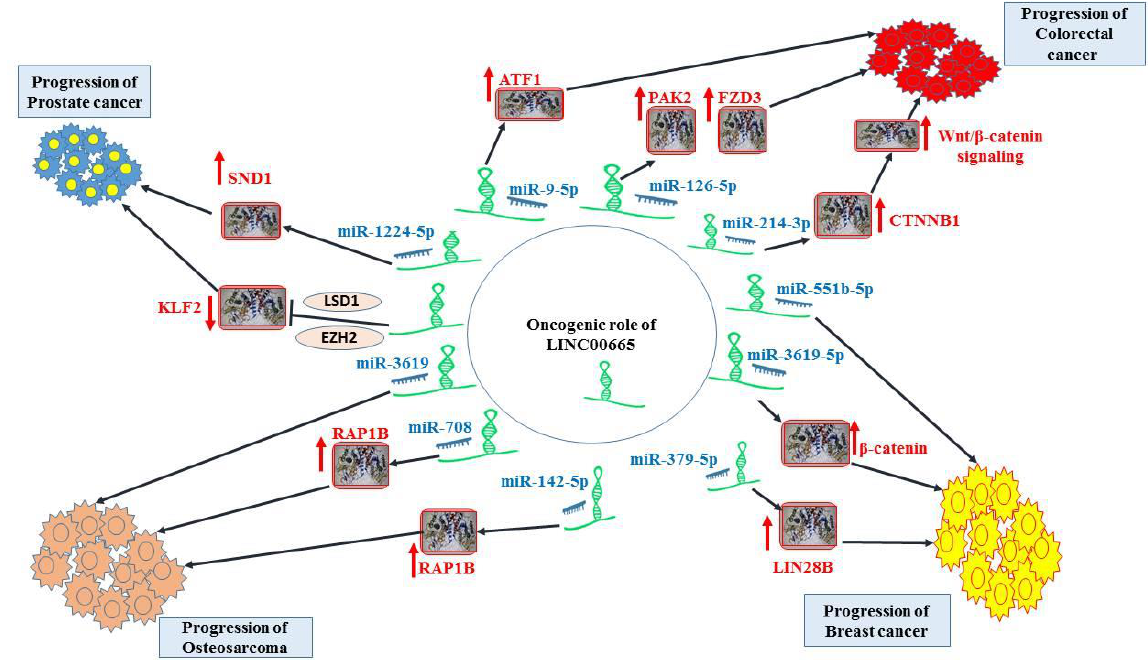
Figure 1. Oncogenic role of LINC00665 in prostate cancer, colorectal cancer, breast cancer, and osteosarcoma. Detailed information about the assays is shown in Table 1.